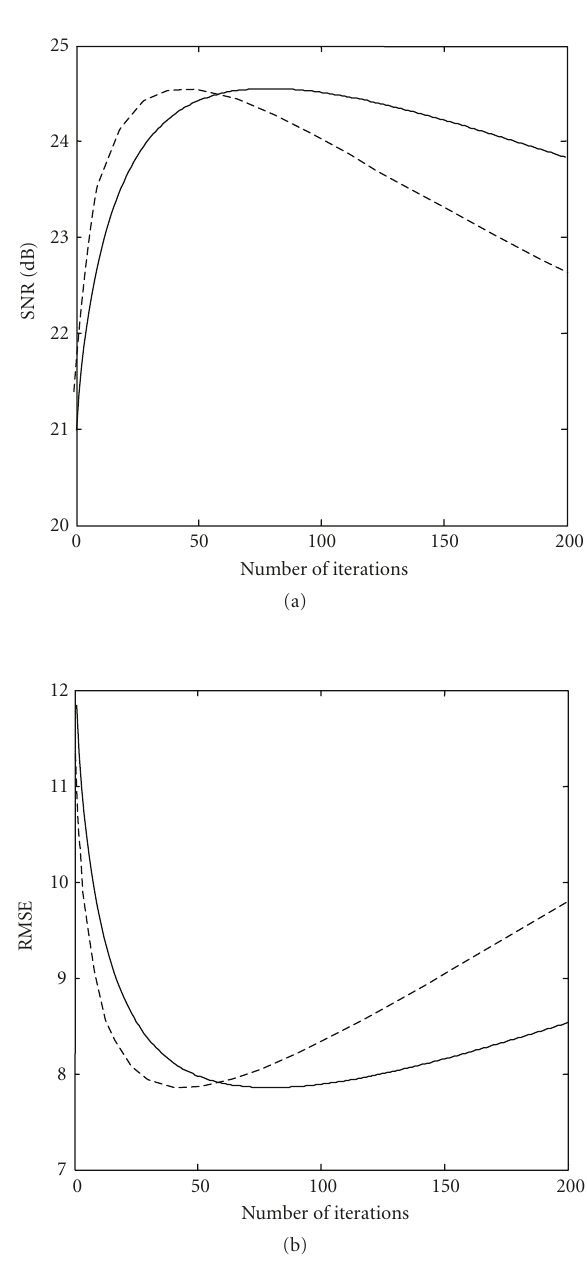
Figure 4: “Lenna” image (a) SNR of the MAPE (solid line) and AAMAPE (dotted line). (b) RMSE of the MAPE (solid line) and AAMAPE (dotted